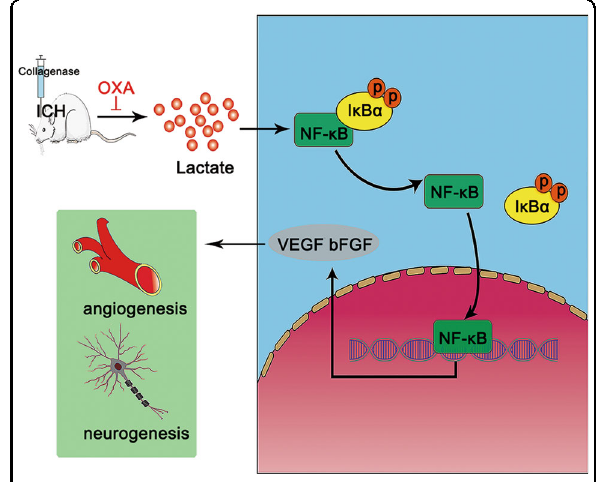
Fig. 6 Lactate potentiates angiogenesis and neurogenesis by activating the NF- κ B signaling pathway following